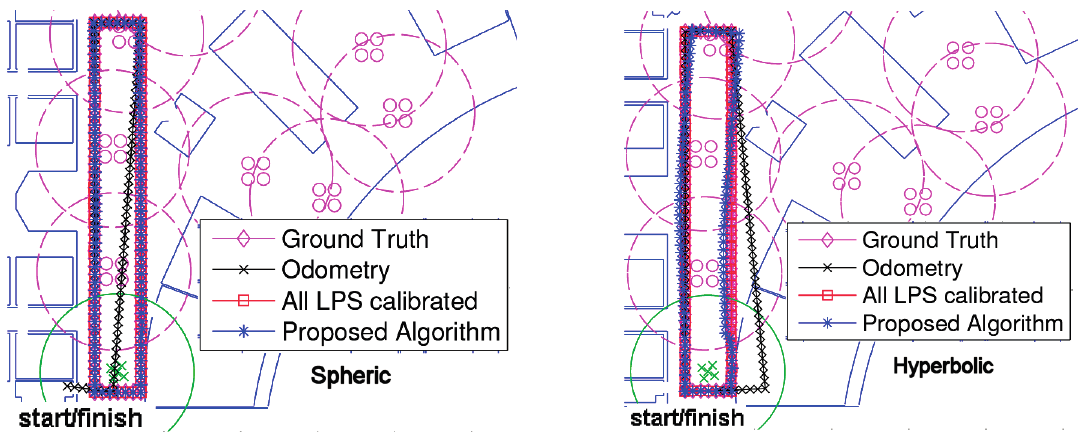
Figure 4. Evaluation of the algorithm for a rectangular trajectory. ( Left ) Spherical case; ( right ) hyperbolic